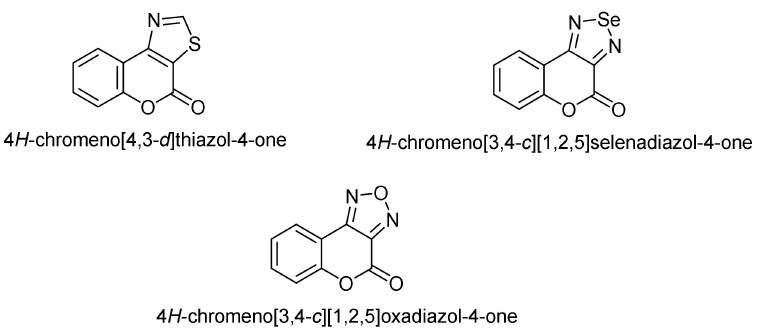
Figure 7. Coumarin-fused five-membered aromatic heterocycles have not been feasible by any synthetic